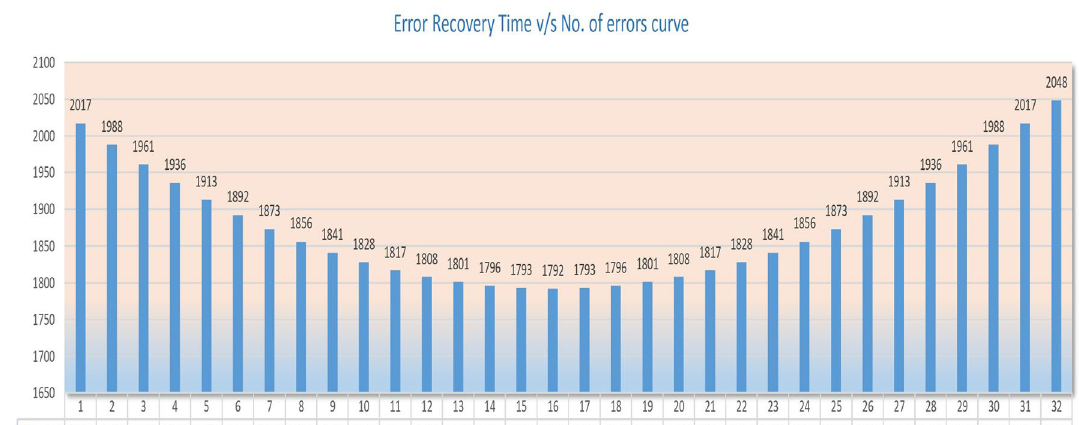
Fig. 19 Error recovery time